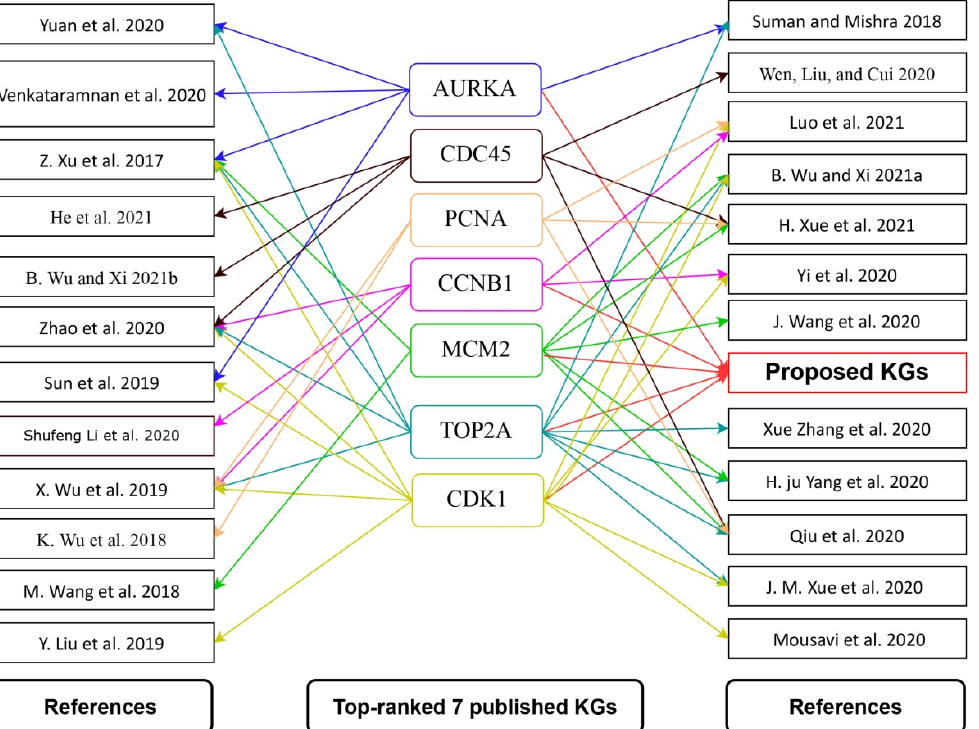
Figure 9. Top-ranked seven published hub genes, five of them identical to our proposed KGs for CC, where the first and third columns indicated different articles, and the second column indicated the top-ranked hub genes, where, red-color connected networks indicated the proposed KGs, and different-color connected networks indicated the different top-ranked hub genes.